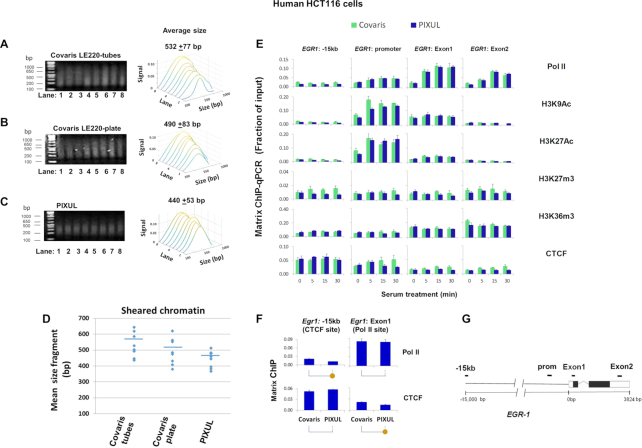
Matrix ChIP analysis of chromatin prepared from 96-well HCT116 cultures using either PIXUL or Covaris LE220. Serum-deprived HCT116 cell 96-well plate cultures were treated with serum for 0, 5, 15 and 30 min. Cells were cross-linked directly in the 96-well plate. With Covaris LE220 shearing harvesting cells from one well of a 96-well plate yielded insufficient amounts of chromatin to generate reproducible ChIP results. Thus, with this instrument, for each time point cells harvested from three wells of a 96-well plate were combined into one sample and transferred to either Covaris microplate tubes or Covaris microplate. Each time point was done in duplicate, for a total of eight samples. The rest of the 96-well plate was sealed and sonicated in PIXUL (18 min treatment). (A–C) Agarose gel electrophoresis analysis of chromatin fragments sonicated using Covaris LE220 microplate tubes (A), Covaris LE220 plate (B) or PIXUL (C). Sheared fragments were analyzed by image analysis software (Methods), results are displayed as waterfall plots in sequential order of samples run from lane 1 to 8 as in Figure 1. X- axis; band size in base pair (bp). Y-axis; sample from a given lane. Z-axis; relative signal intensity of bands. Numbers above the plots show average fragment size ±SEM for all eight samples. (D) Sizes of chromatin samples (A-C) sonicated by either Covaris tubes, Covaris plate or PIXUL. (E) Sheared chromatin samples prepared using either Covaris tubes (cells from 3 wells combined into one sample) and PIXUL (single well per sample) were analyzed simultaneously by Matrix ChIP using antibodies to Pol II, H3K9Ac, H3K27Ac, H3K27m3, H3K36m3 and CTCF. ChIP DNA was analyzed by qPCR using indicated primers. Results show fraction of input, mean±SEM (n = 3 replicates for each time point for each instrument). (F) Comparison of Pol II and CTCF ChIP signals at known binding and respective distal sites using Covaris versus PIXUL sonicated chromatin (yellow circles below graphs show P < 0.05). (G) EGR1 gene cartoon and position of PCR primers. This comparison demonstrates that sonication of chromatin with PIXUL is more consistent and yields smaller fragments compared to Covaris; in particular the first position (A1) in their plate yields considerably smaller fragment than the other wells. Combing cells from three wells of a 96-well plate for Covaris sonication generates chromatin yielding similar ChIP results to those obtained using cells from one well of a 96-well plate treated with PIXUL. The ChIP background signal is lower with PIXUL compared to Covaris.